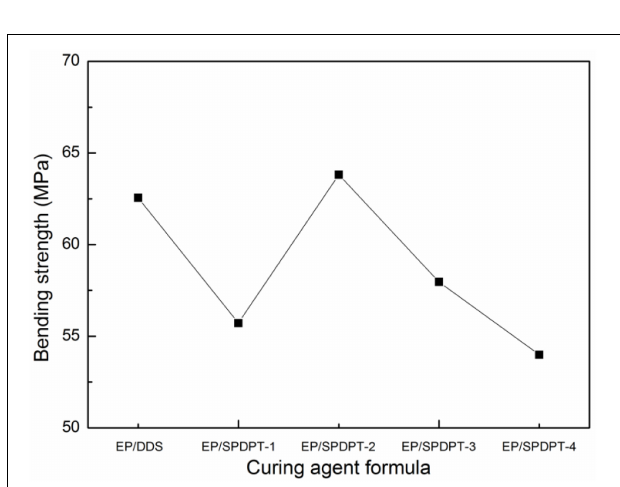
FIGURE 9 | Bending properties of epoxy thermosets.